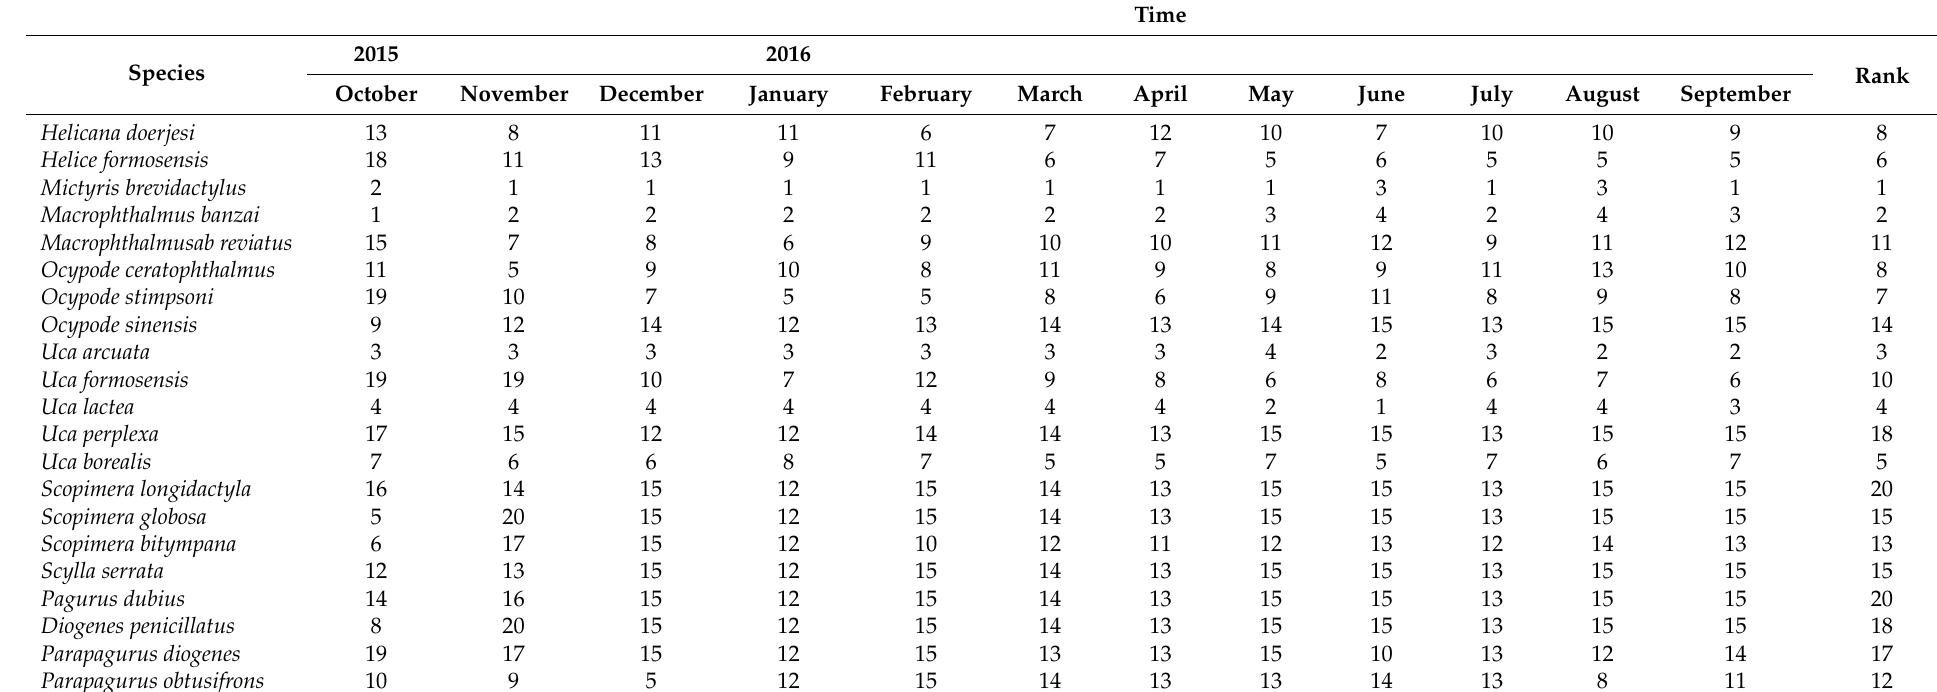
Table A2. Monthly rankings in terms of probability of contributing to biodiversity ( H (cid:48) c.k.m.